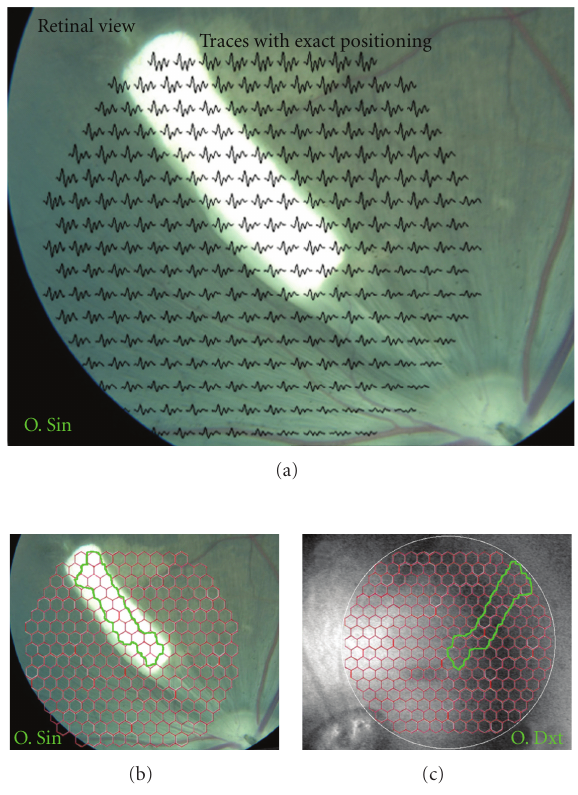
Figure 2: Fundus photos of both eyes 6 weeks after blue PLGA transplantation. (a) Color fundus photo aligned with multifocal electroretinographic (mfERG) traces of the 241 unscaled stimulated hexagons. The membrane is surrounded by choroidal neovascu- larization but does not appear to reflect light in the manner of the white PLGA. (b) Color fundus photo of the left membrane- transplanted eye aligned with hexagon grid used for mfERG recording. Area included as membrane is marked with a green line. (c) Infrared fundus photo of fellow right untouched eye with hexagon grid used for mfERG recording. The green line marks area included at membrane corresponding area for calculation of P1- amplitude